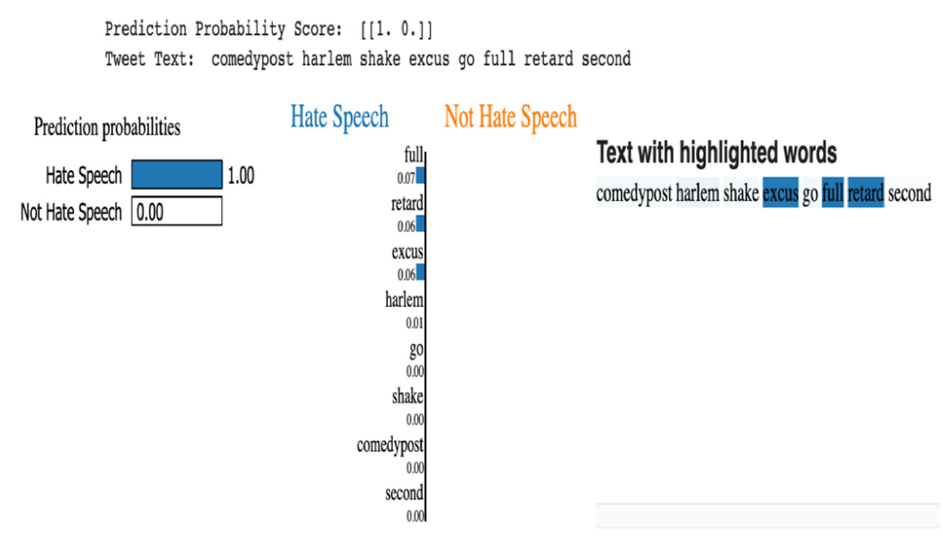
Figure 9. Explainability with decision tree.